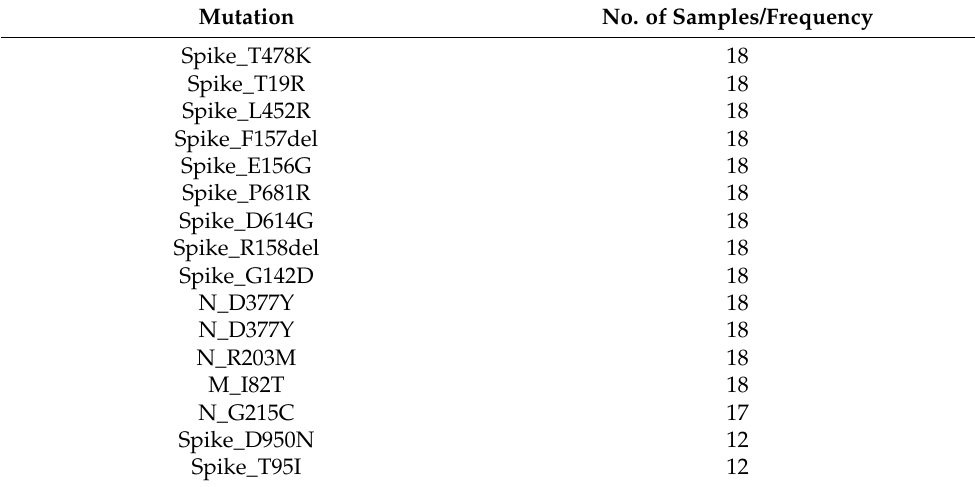
Table 3. Mutational frequency in structural proteins.